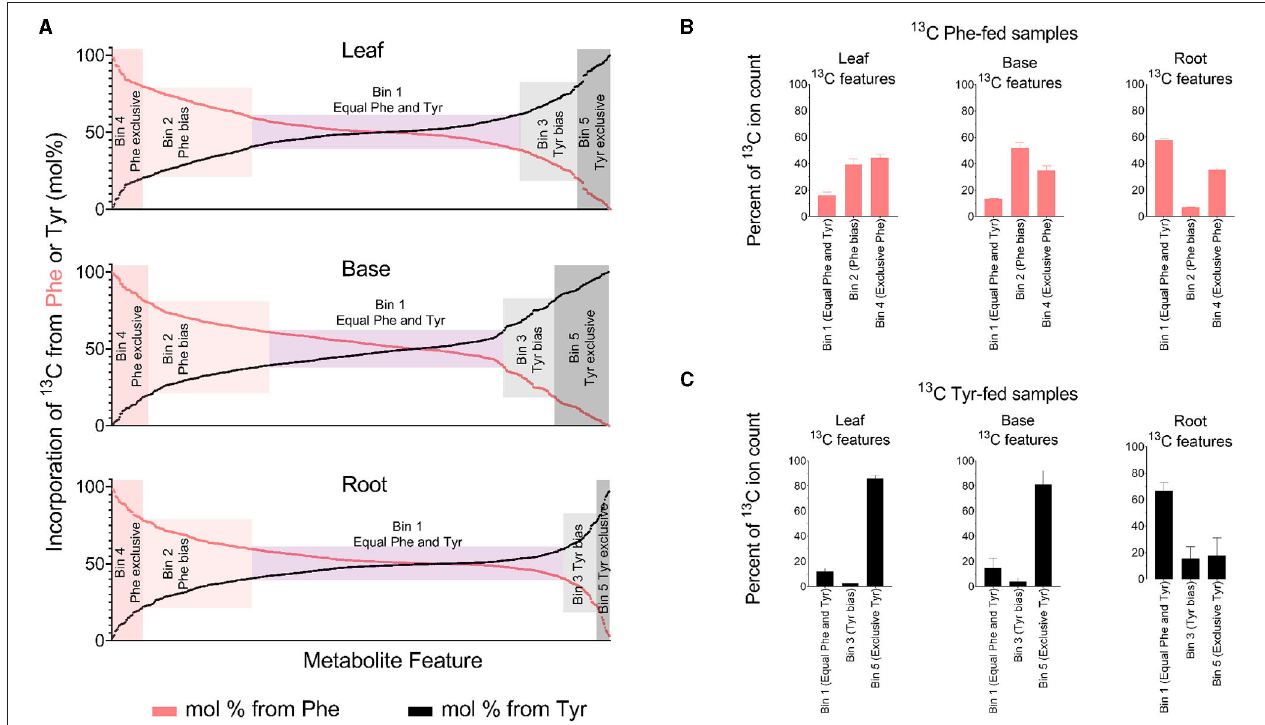
FIGURE 4 | Quantified incorporation of Phe and Tyr into metabolite features. (A) Incorporation of 13 C Phe and 13 C Tyr, expressed as a mol%. The percent 13 C incorporation was determined for every peak-pair in 13 C-fed tissues by dividing the ion counts in the 13 C-containing features by the sum of the ion counts in its combined 12 C- and 13 C-containing features. Each feature was then assigned a mol% based on 13 C 6 incorporation from Phe or Tyr. A metabolite feature with 90 mol% labelings from Phe will have a Tyr-derived mol% labeling value of 10, and both of those values are plotted on the graph. For (A) , the t -test filter that was used to generate Table 1 and (B,C) was omitted. Thus, (A) includes several MS features that did not meet the t -test criteria but had a mol% enrichment value assigning them to one of the five bins ( Supplementary Table 2 ). (B,C) Aggregated ion counts from 13 C Phe (B) or 13 C 6 Tyr (C) into metabolite features in each labeling bin that is described in Table 1 . For (B,C) , the y-axis refers to the ion count in Phe and Tyr-derived features as a percentage of the ion count in all detected metabolite features comprising the FDM and YDM,